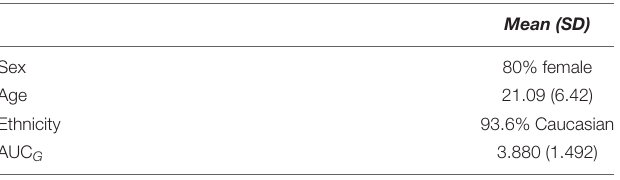
TABLE 1 | Characteristics of the study sample for cohort that participated in both sessions of the